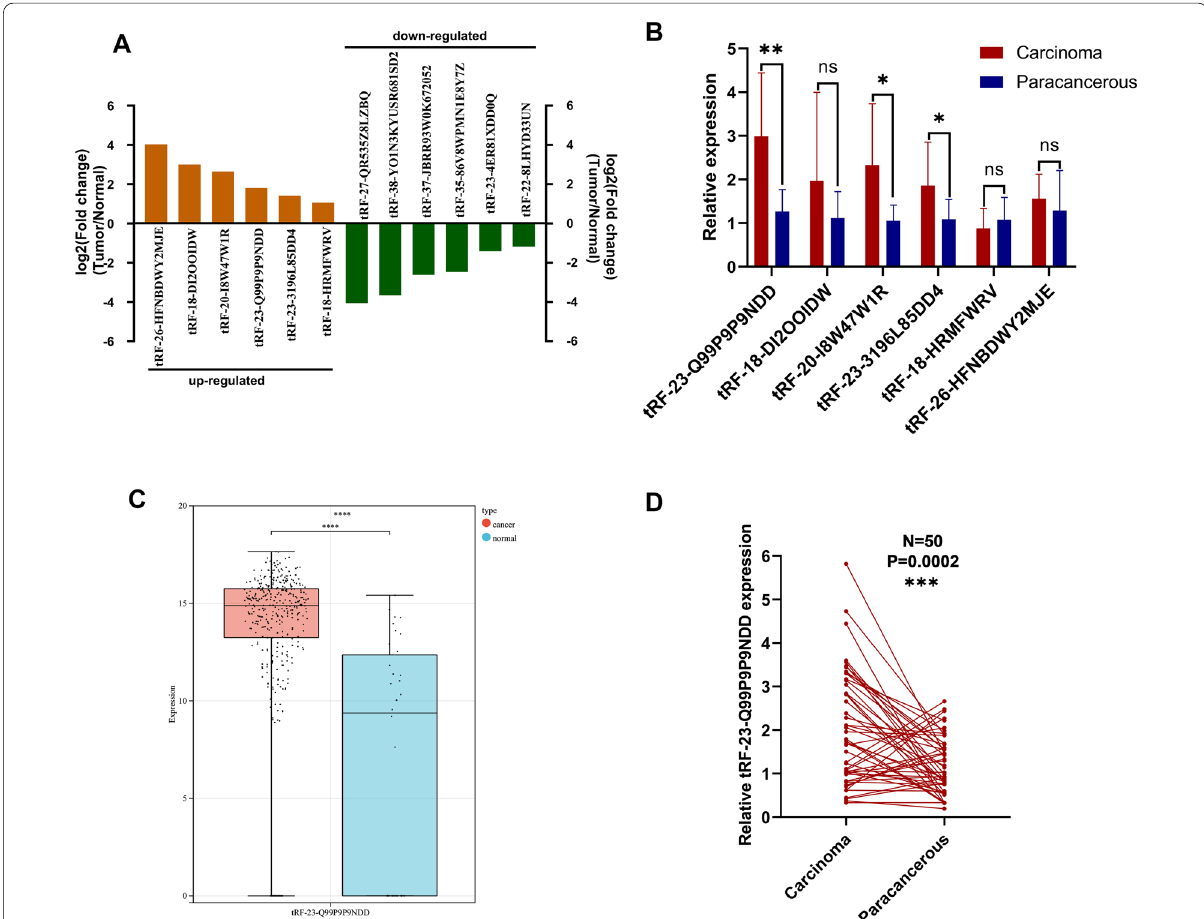
Fig. 1 The expression profiles of tsRNAs in GC and the screening of tRF-23-Q99P9P9NDD. A Differential expression of tsRNAs-seq in GC tissues and matched para-cancer tissues, with 6 tsRNAs up-regulated (log2 fold change > 1, P < 0.05) and 6 down-regulated (log2 fold change < P < 0.05). B Relative expression of six highly expressed tsRNAs in 10 pairs of GC tissues. C Differential expression of tRF-23-Q99P9P9NDD in the TCGA stomach adenocarcinoma database of GC and normal samples. D The expression levels of tRF-23-Q99P9P9NDD in 50 pairs of GC tissues and their para-cancer tissues. *P < 0.05; **P < 0.01; ***P < 0.001; ****P < 0.0001